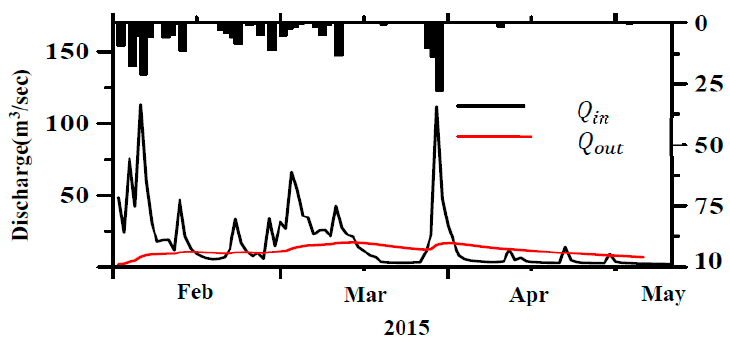
Figure 12. The simulated total inflow to, and outflow from, the lake (2015: rainy season).